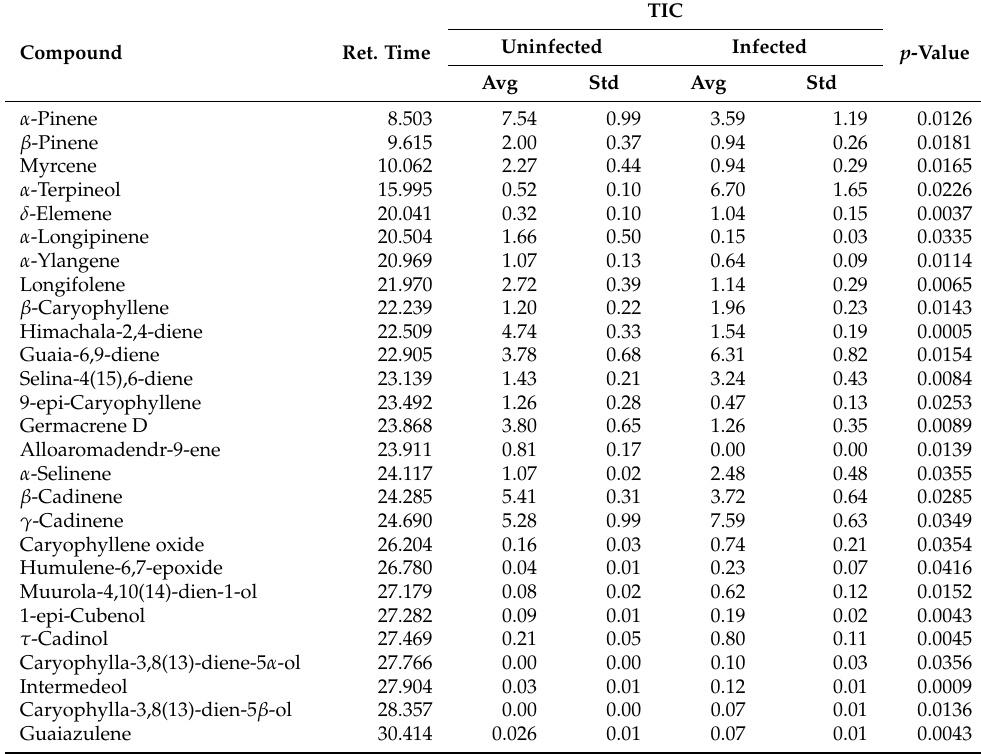
Table A3. Volatile Organic Components identified by the Gas Chromatography–Mass Spectrometry measurements. The average (avg) and standard deviation (std) of the percentage of the Total Ion Current (TIC) are calculated from repetitions of all studied samples measurements. Only components, which differs for two studied categories are listed ( p -value below 0.05). Data are sorted by retention time (in minutes).